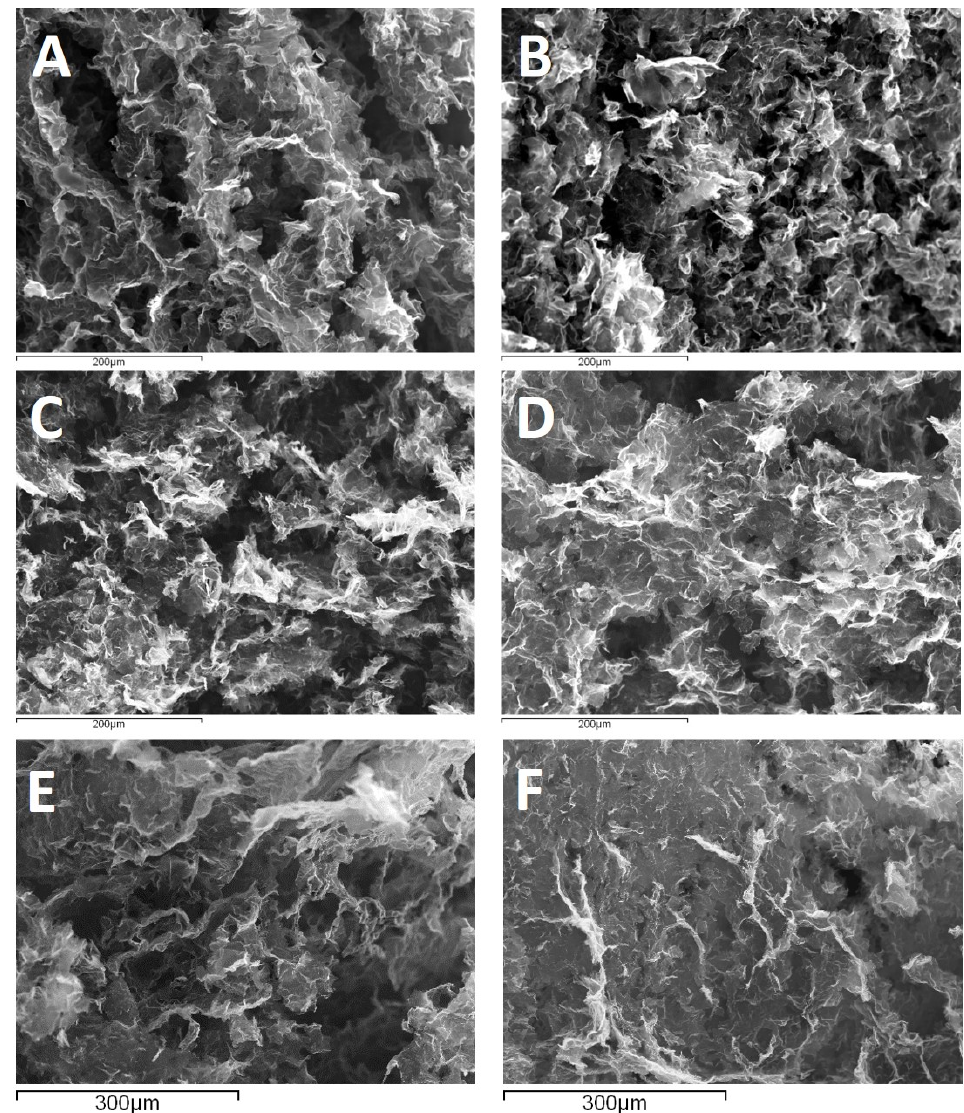
Figure 3. SEM images of EDA-functionalized GO aerogels. At 165 °C, 12 h, a 2 mg·mL − 1 GO dispersion where GO/EDA = 1:2.5 ( A ) and 1:6 ( B ). From a 2 mg·mL − 1 GO dispersion at 140 °C where GO/EDA = 1:2.5 for 12 h ( C ) and 18 h ( D ). From a 2 mg·mL − 1 GO dispersion ( E ) and a 10 mg·mL − 1 dispersion ( F ) where GO/EDA = 1:2.5 at 85 °C.